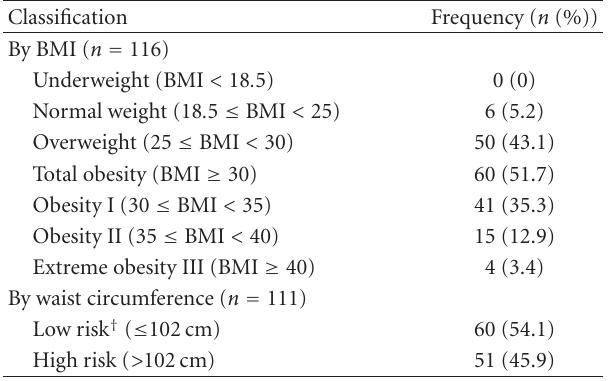
Table 2: Distribution of participants by body mass index and by waist circumference.